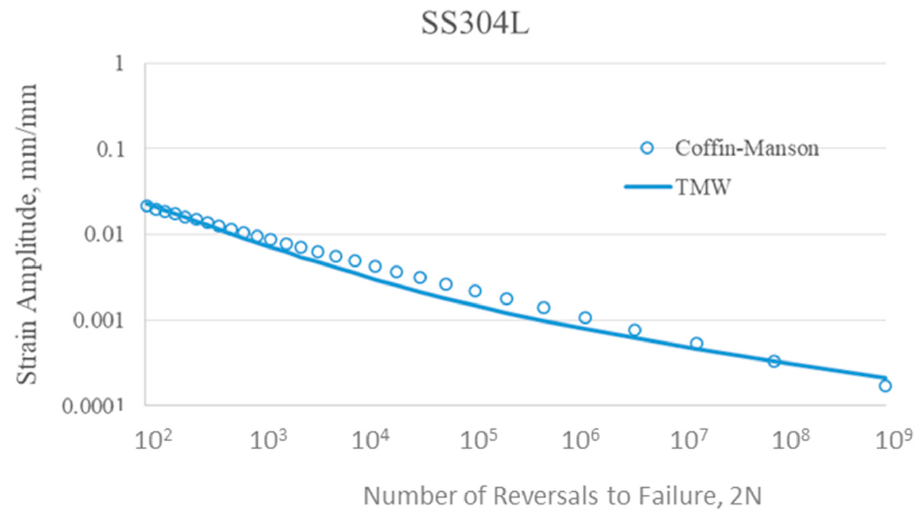
Figure 7. The predicted fatigue life by the TMW model in comparison with the best-fit Coffin-Manson relation for the test data.